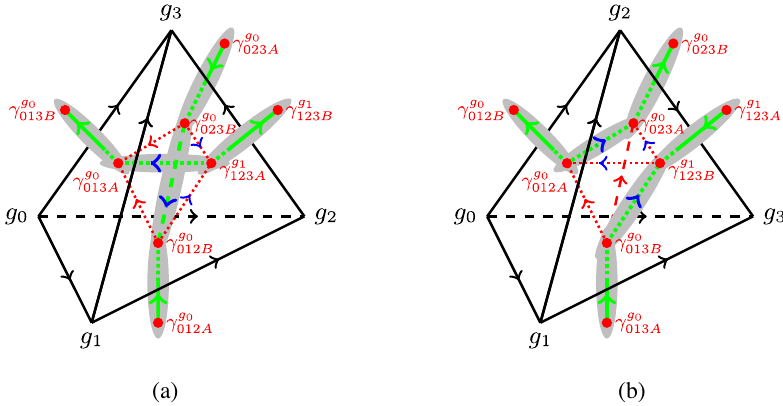
FIG. 10. Resolvation of four strings of Kitaev chains meeting at one tetrahedron. If four strings (green lines) meet at one tetrahedron, we should pair the Majorana fermions γ g 1 123 tetrahedron. We omit the labels of Majorana fermions ( γ σ tetrahedron (b) Negative oriented